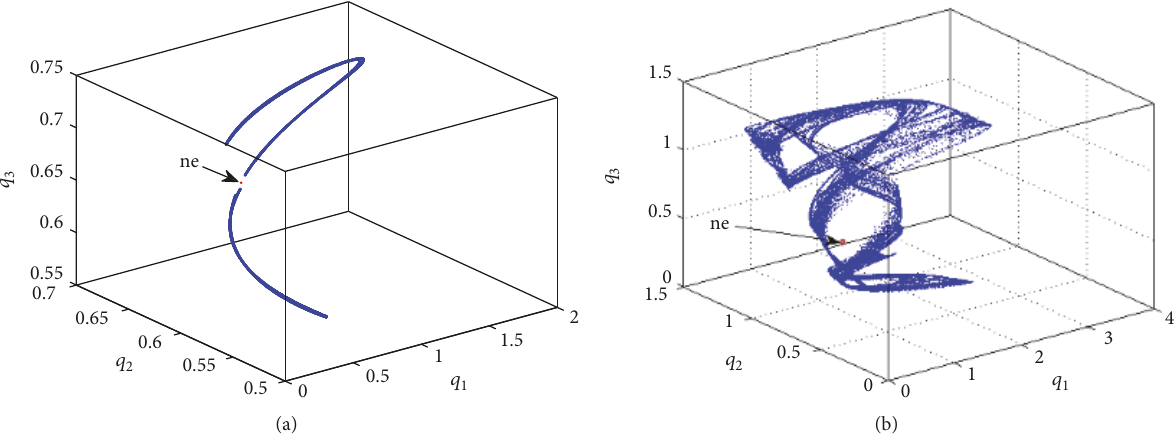
Figure 6: Phase portrait at (a) 𝑘 1 = 10 , 𝑘 2 = 4 , 𝑘 3 = 5 , 𝑐 1 = 0.19 , 𝑐 2 = 0.18 , 𝑐 3 = 0.17 (b) 𝑘 1 = 10 , 𝑘 2 = 8 , 𝑘 3 = 9 , 𝑐 1 = 0.19 , 𝑐 2 = 0.18 , and 𝑐